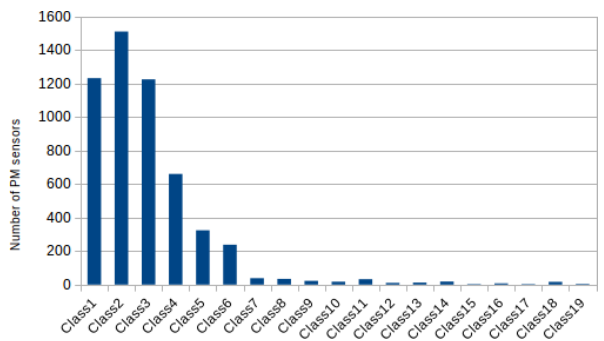
Figure 14. Classes of coverage in 10km intervals.